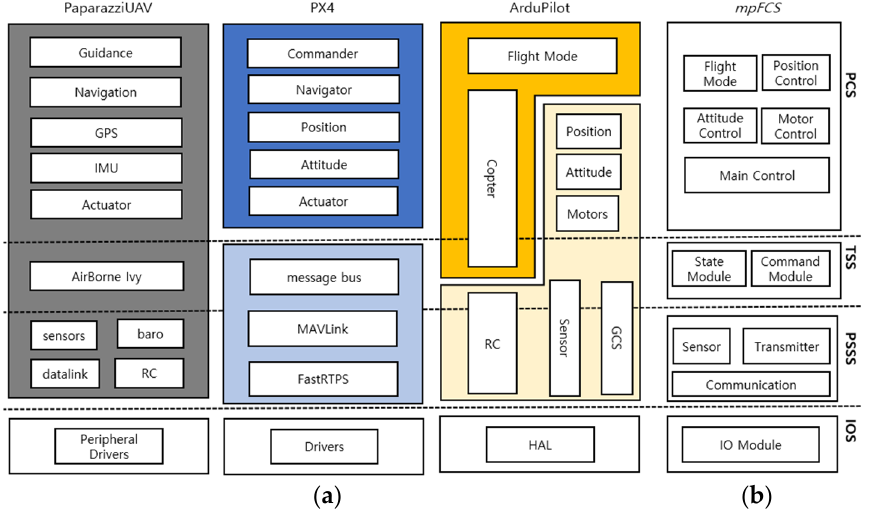
Figure 5. The analysis of the modules of open-source software and the mpFCS . ( a ) Open Source (PaparazziUAV, PX4, ArduPiolot). ( b ) mpFCS .